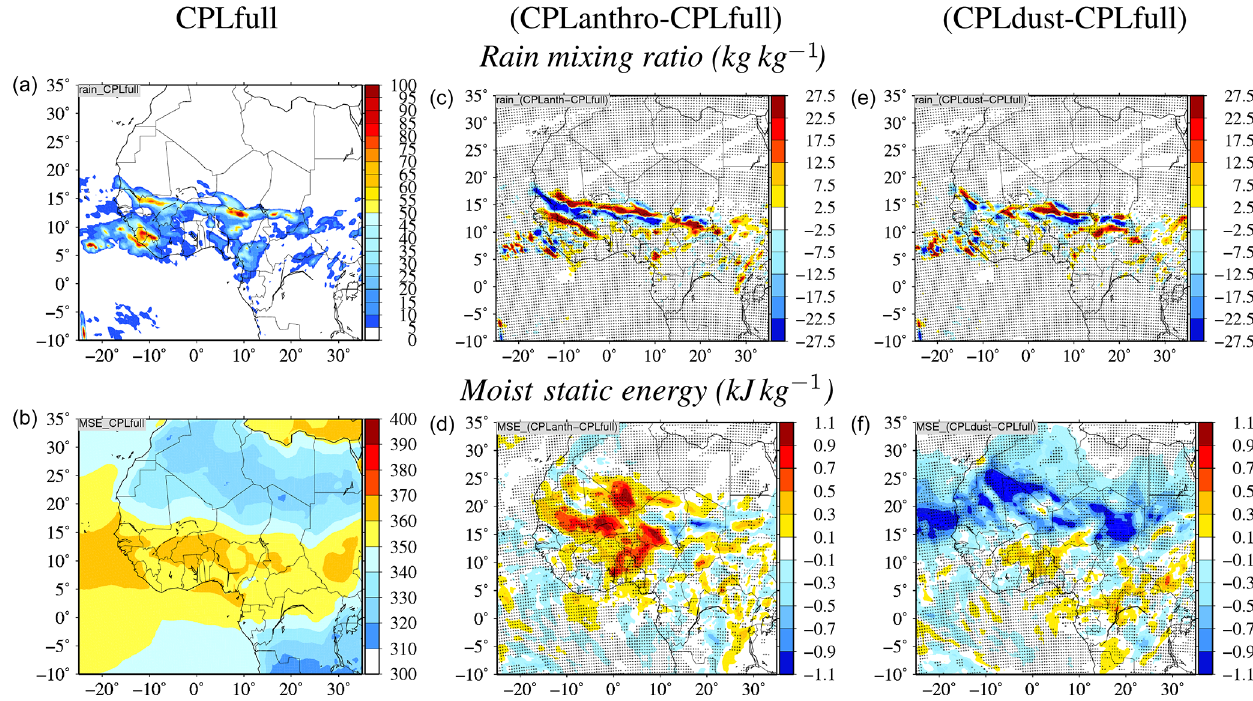
Figure 8. (a, b) Maps of the monthly mean rain mixing ratio (kgkg − 1 ) and moist static energy (kJkg − 1 ) for July 2016. (c, d) Maps of the monthly mean of daily averaged differences between CPLanthro and CPLfull for the same variables as the left row. (e, f) Maps of the monthly mean of daily averaged differences between CPLdust and CPLfull for the same variables as the left row. The tiny crosses on the map indicate where the difference was found to be